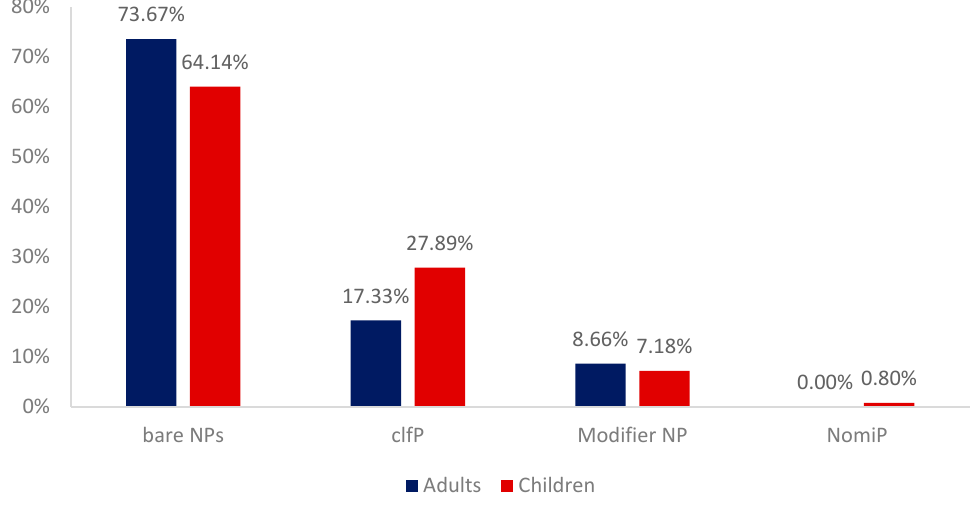
Figure 5. Mean proportions of the types of conjunct NPs in child and adult speech. (clfp = classifier phrase; NomiP = nominalized verb phrase).